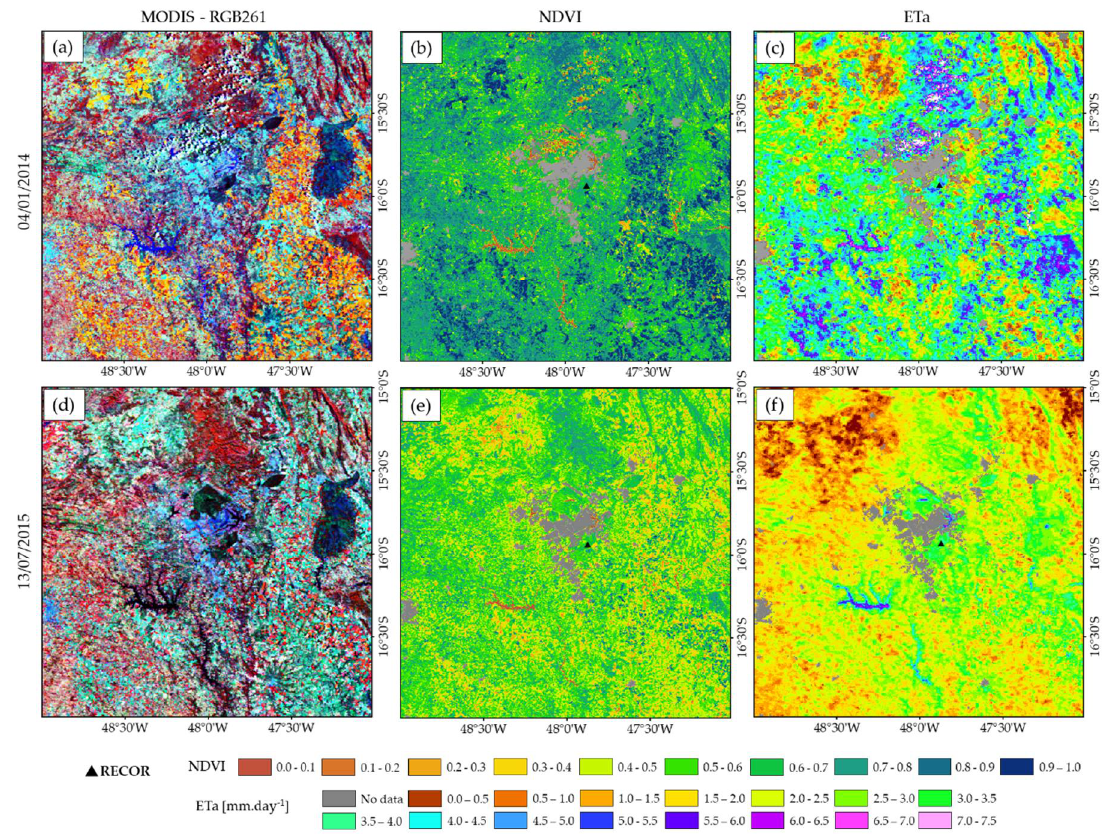
Figure 9. RGB Color composites for MODIS bands (RGB261), Normalized Difference Vegetation Index (NDVI), and actual evapotranspiration (ETa) simulated by METRIC for dates of ( a – c ) 4 April 2014 (wet season) and ( d – f ) 13 July 2015 (dry season) for the study area near Brasília-DF. Gray pixels are urban areas extracted from TerraClass thematic map.